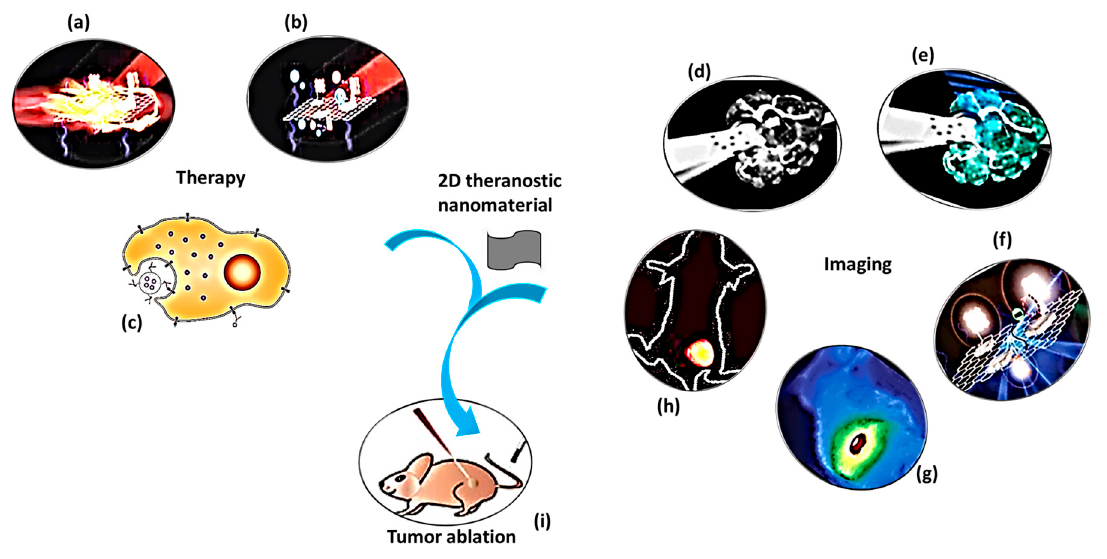
Figure 1. A schematic diagram showing theranostic treatments of 2D theranostic nanomaterials such as photothermal therapy ( a ), photodynamic therapy ( b ) and chemotherapy ( c ) with their astonishing imaging properties, including magnetic resonance ( d ), photoacoustic ( e ), fluorescence ( f ), infra-red thermal ( g ), and upconversion luminescence imaging ( h ) to eradicate cancer tumor ( i ) effectively. The images ( a ), ( b ), ( f ), and ( i ) were adapted with permission from [79]. The image ( c ) was adapted with permission from [80]. The images ( d ) and ( e ) were adapted with permission from [81]. The image ( g ) was adapted with permission from [37]. The image ( h ) was adapted with permission from [82].